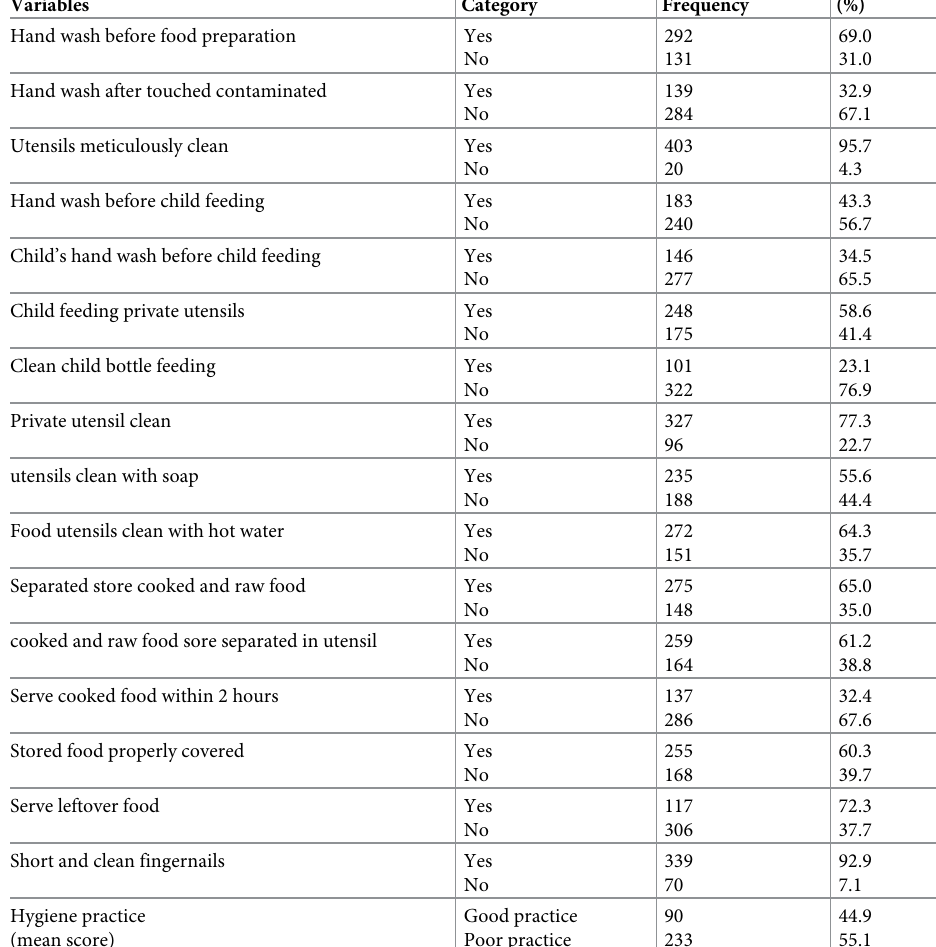
Table 5. Frequency of each hygiene practice during complementary food preparation with 6–24 months aged of children in Debark town northwest Ethiopia, 2021(n = 423).